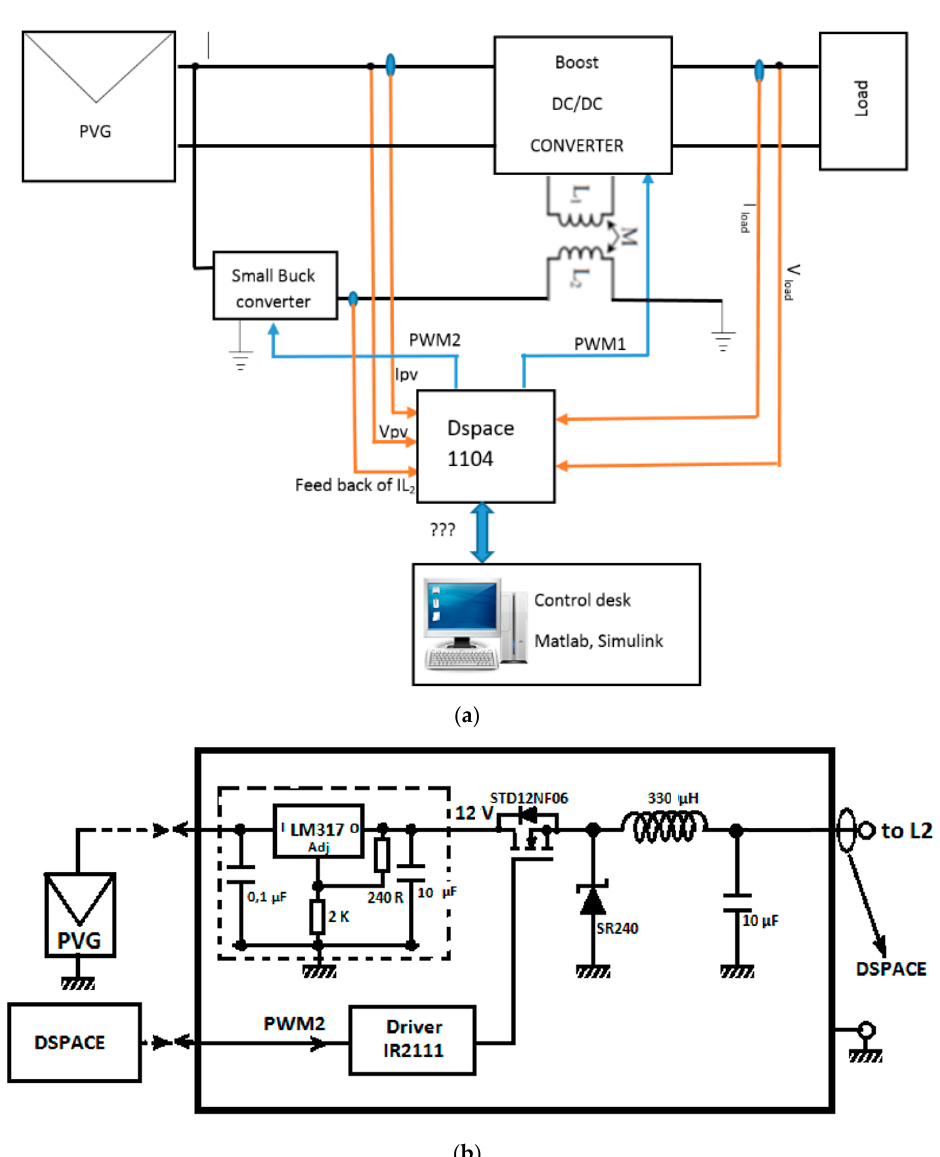
Figure 16. ( a ) Schematic of the experimental setup for the proposed boost DC/DC converter. ( b ) Schematic of the small Buck converter.